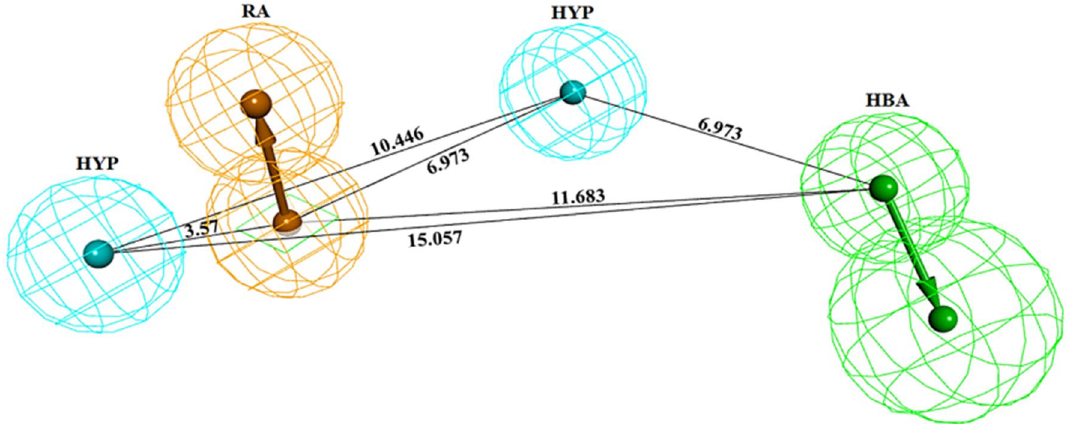
Figure 2. The best pharmacophore model ‘Hypo 1’, with distance constraints. Hypo 1 contains one hydrogen bond acceptor (HBA: green), one ring aromatic (RA: orange), and two hydrophobic regions (HYP: cyan).The figure is drawn using DS v3.5.